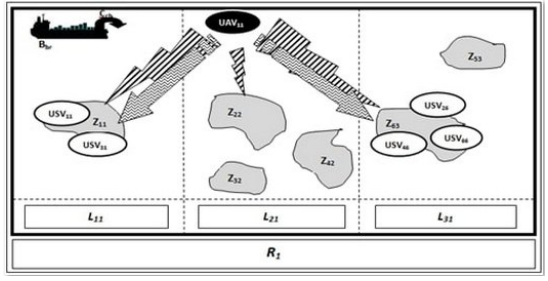
Figure 13: UAV-M planning